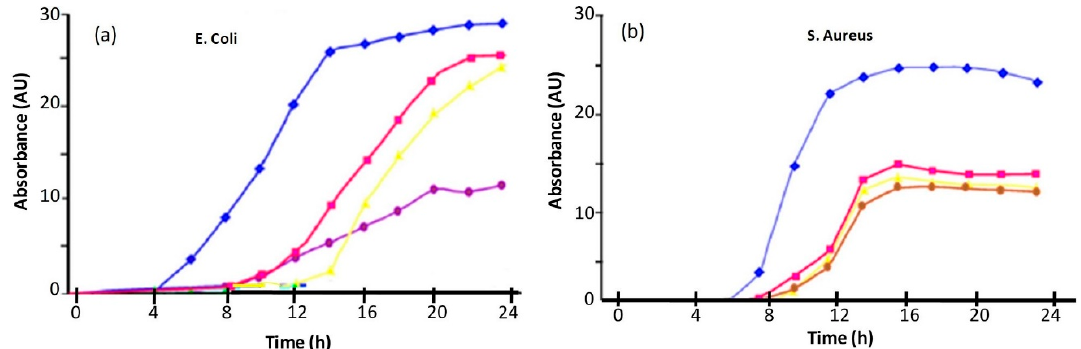
Figure 12. Absorbance versus time showing the effect of LO/CuO nanocomposites on the growth of E. coli (a) and S. aureus (b). – control; – 0.04 % CuO; – 0.05 % CuO; – and –0.06 % CuO; Adapted from [50], copyright 2013, with permission from Elsevier.